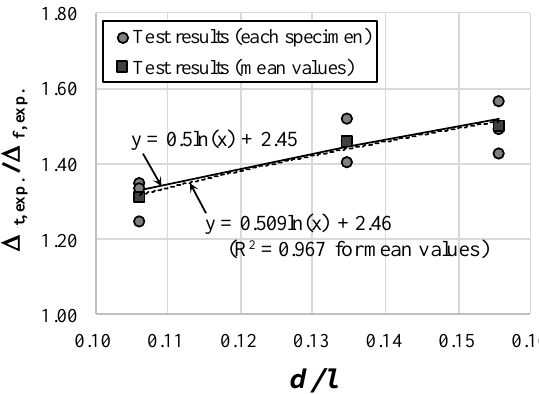
Figure 7. Regression analysis of experimental results. Table 3. Comparison of Observed and Predicted Results of Flexure-Critical RC Beams Reported in the Literature.